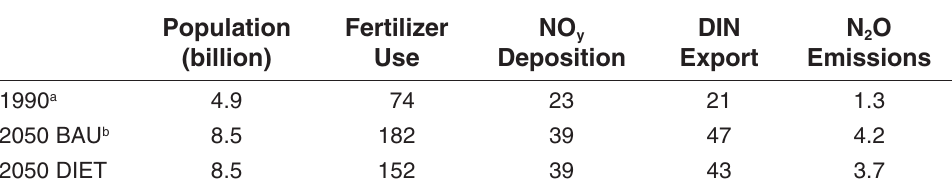
Worldwide Totals for N-Model Inputs of Population, Fertilizer Use, and NO Deposition Rates in Exoreic Watersheds. Calculated DIN Export Rates by Rivers and Associated N O Emissions in Rivers and Estuaries, for the Year 1990 and Two 2 Scenarios For 2050 (Units: Tg N/Year Unless Mentioned Otherwise)